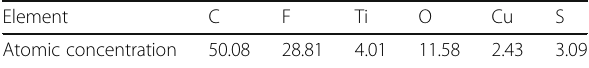
Table 1 The atomic concentration of element in Cu 1 sample Element C